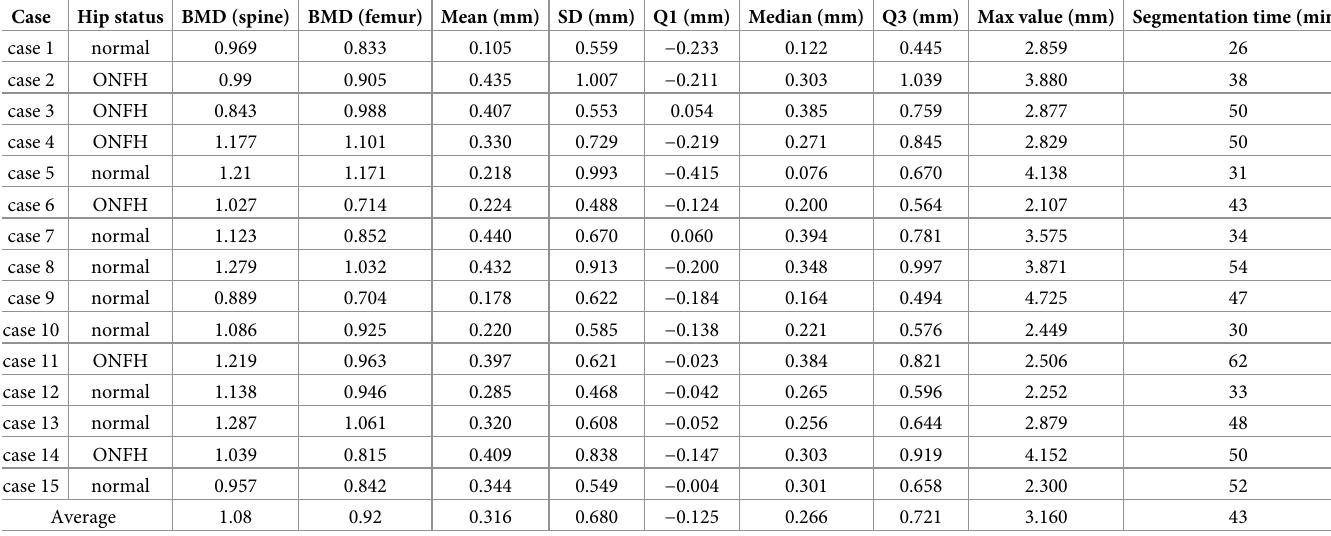
Table 3. Image registration error for the total hip between 3D-CT and 3D-MRI using the Dixon method.